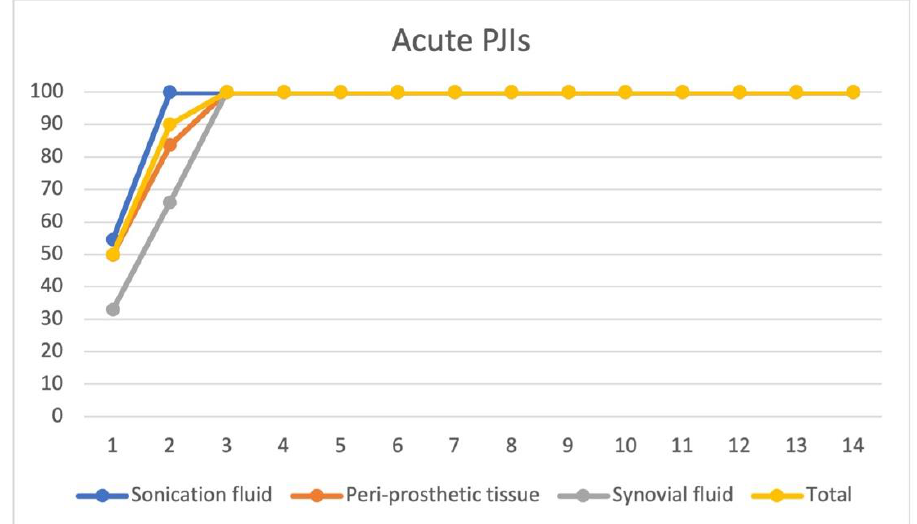
Figure 2. Time to positivity for bacterial cultures for acute PJI cultures. Time to positivity plotted against the percentage of culture positivity in acute (n = 11 patients) PJIs as a total (from all clinical samples), and from different clinical samples (sonication fluid cultures, periprosthetic tissue cultures, and synovial fluid cultures). On the vertical axis—culture positivity (%), and on the horizontal axis—time to positivity (days).